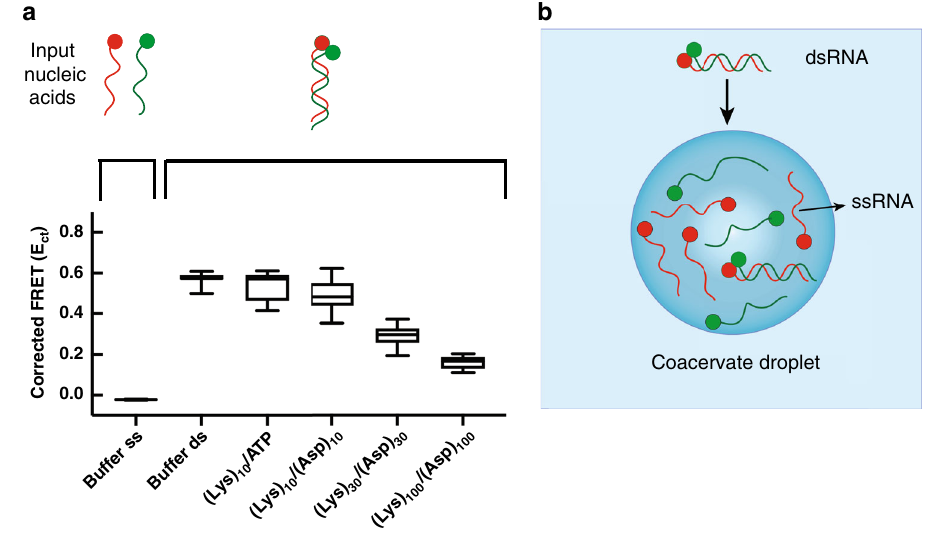
Fig. 5 Double helix structure of 10mer RNA in coacervate droplets. a Corrected FRET values calculated for RNA in K 15 M 0.5 T 10 buffer alone (left-most bar) and in different coacervate samples (righthand set of bars). The FRET single-stranded, noncomplementary control was performed by mixing Cy3 and Cy5-labeled oligonucleotides of the same sequence (see Supplementary Table 5). *Due to low accumulation in the (Lys) 100 /(Asp) 100 coacervates, a slight excess of the polycation was added (charge ratio 1.2: 1) to increase RNA concentration in the droplets, and the amount of dsRNA added was increased from 0.1 to 1 µ M. b Schematic representation of dsRNA 10mer in coacervate systems, which are composed of (Lys) 30 /(Asp) 30 and (Lys) 100 /(Asp) 100 . Center lines show the medians; box limits indicate the 25th and 75th percentiles; whiskers extend maximum and minimum data points. Error bars show standard deviation of measurements of average of 27 samples over analysis of three independent